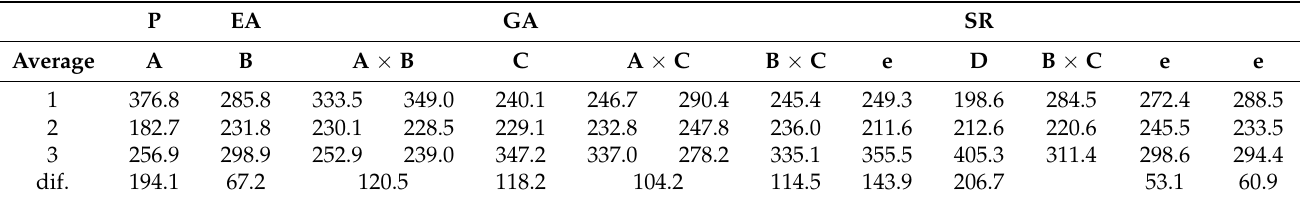
Table 5. Analysis of the relative contribution of the parameters based on the mean concentration of